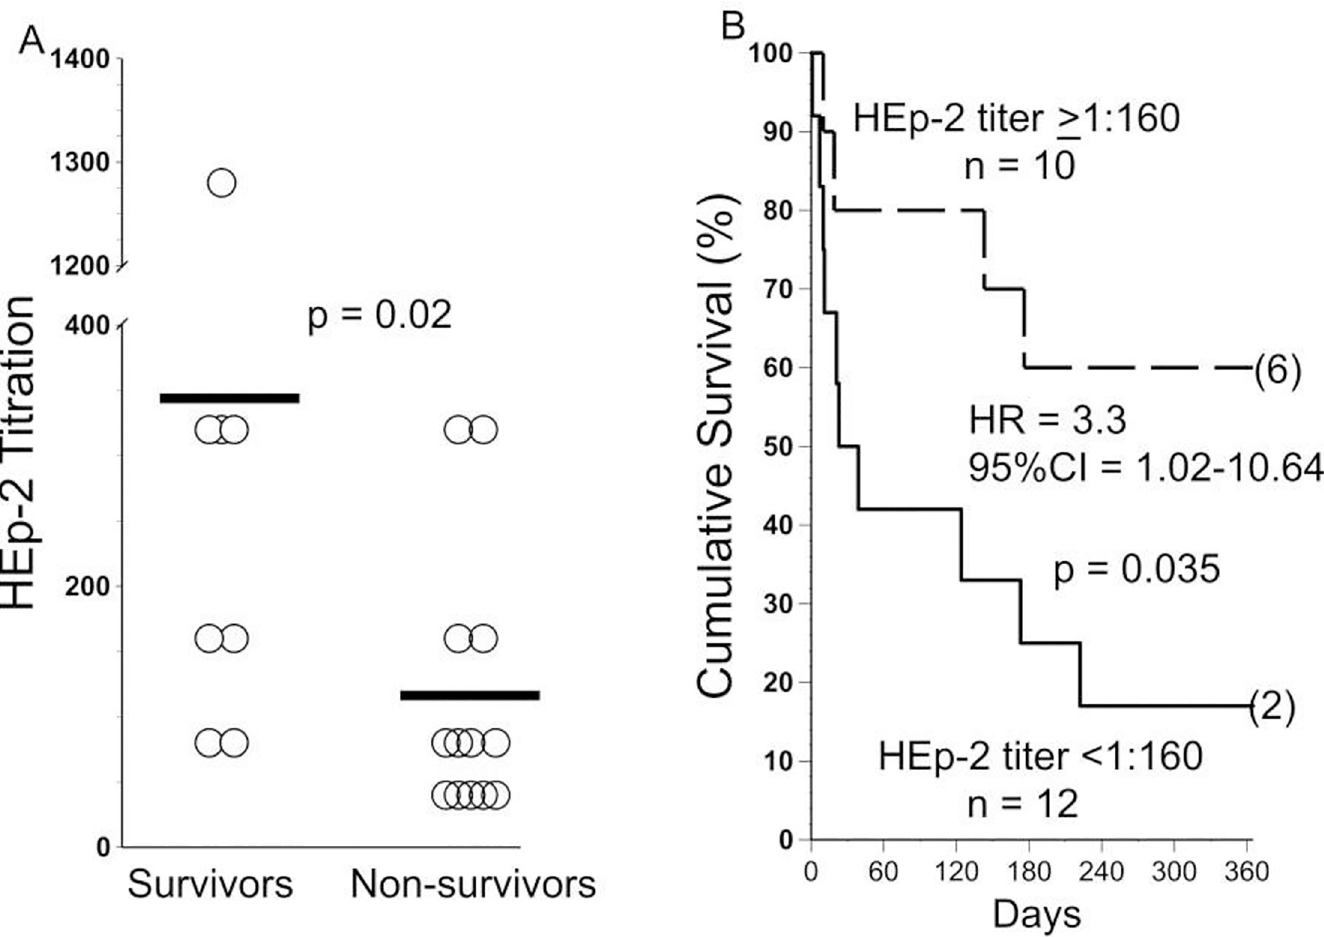
Fig 3. HEp-2 titers and outcomes. A) Anti-HEp-2 titers (denoted here as 1:x) were greater among AE-IPF patients who survived for 12 months, compared to those who succumbed. Horizontal lines denote means. B) Cumulative survival of subjects with anti-HEp-2 titers > 1:160 vs . survivals of those with lesser titers. HR = hazard ratio; 95%CI = 95% confidence interval. Number in parentheses denotes subjects censored at the end of the observation period.